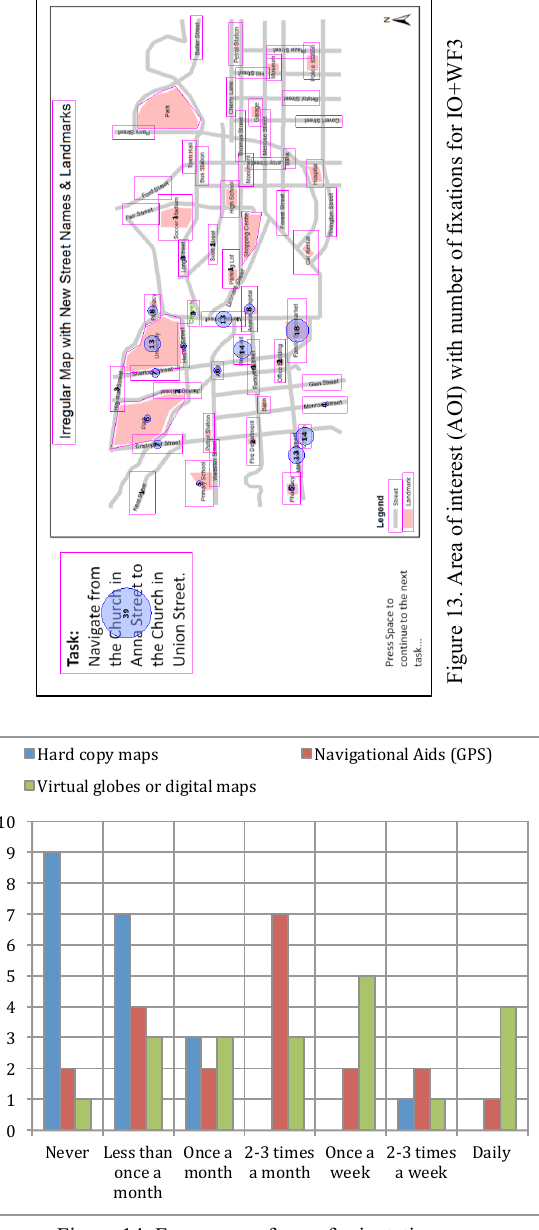
Figure 14. Frequency of use of orientation